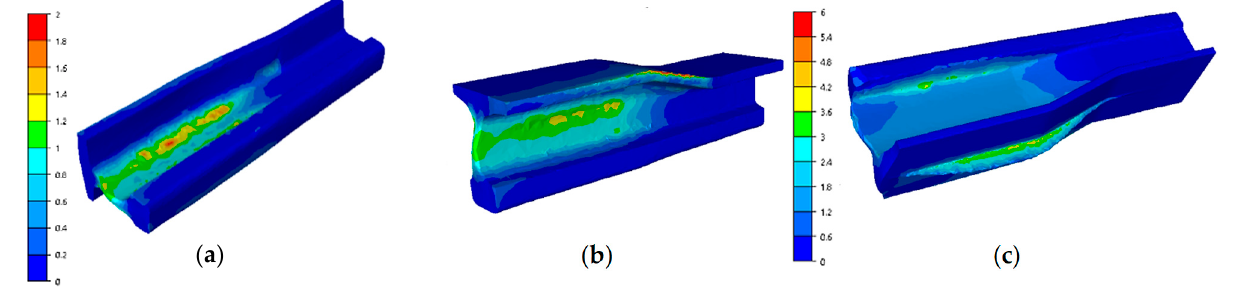
Figure 7. Simulation results—plastic deformation distributions: ( a ) after forging operation I,